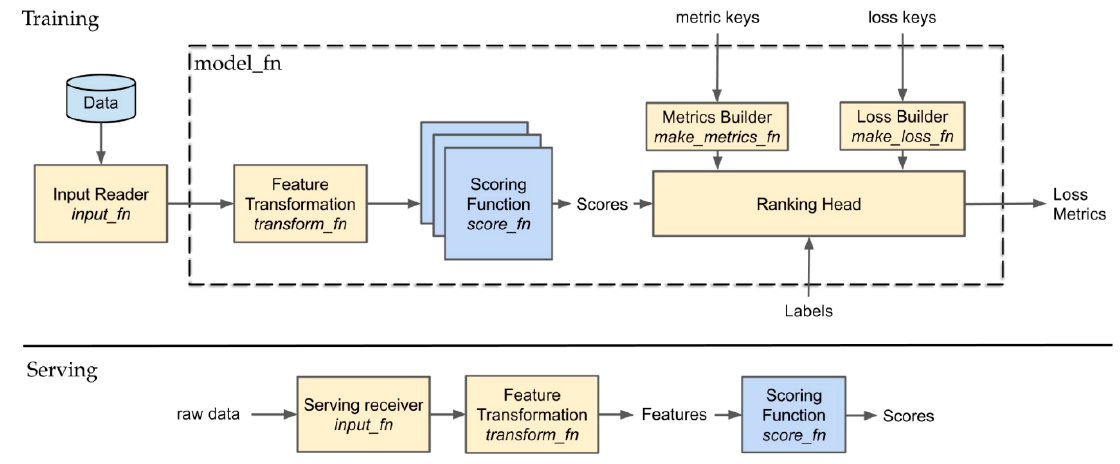
Figure 11. TF-Ranking model to prioritize bridges based on multi-criteria decision factors [44] (the prepared training data are fed into the model, deep features of ranking create a scoring function, and the model is evaluated using the defined loss metrics. Lastly, the trained model is served, and ranking scores are predicted from the input raw data).